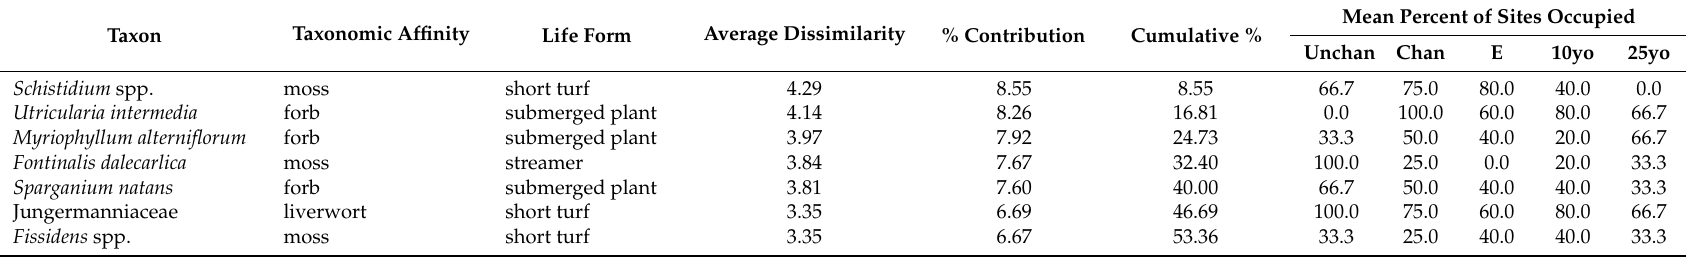
Table A6. SIMPER analysis of macrophyte taxa primarily responsible for the differences among streams that were unchannelized references (Unchan), channelized